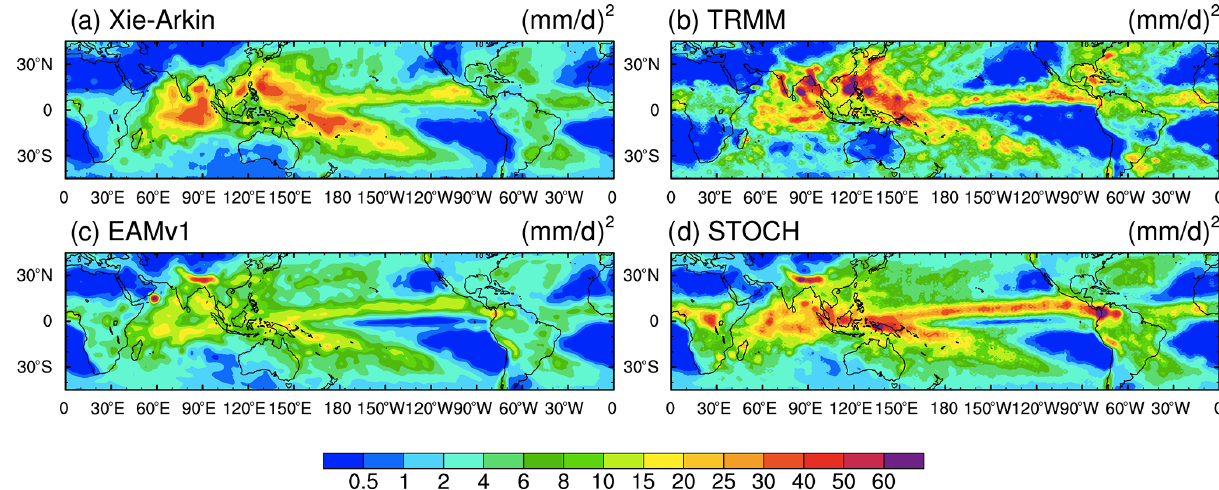
Figure 1. Spatial distributions of the 20–80d variance of rainfall from (a) the Xie–Arkin observations, (b) TRMM, (c) EAMv1 and (d) STOCH (units: mm 2 d − 2